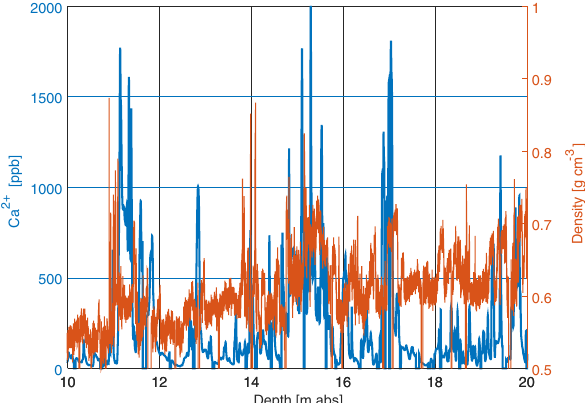
Figure 10. Example view on comparing the KCC Ca 2 + record with the density profile. Density was measured at high resolution by computer tomography at the Alfred Wegener Institute Bremerhaven (Johannes Freitag, personal communication, 2017). The compari- son illustrates the connection between dust content and presumed faster snow consolidation: layers of high dust load coincide with layers of enhanced density (with respect to ambient